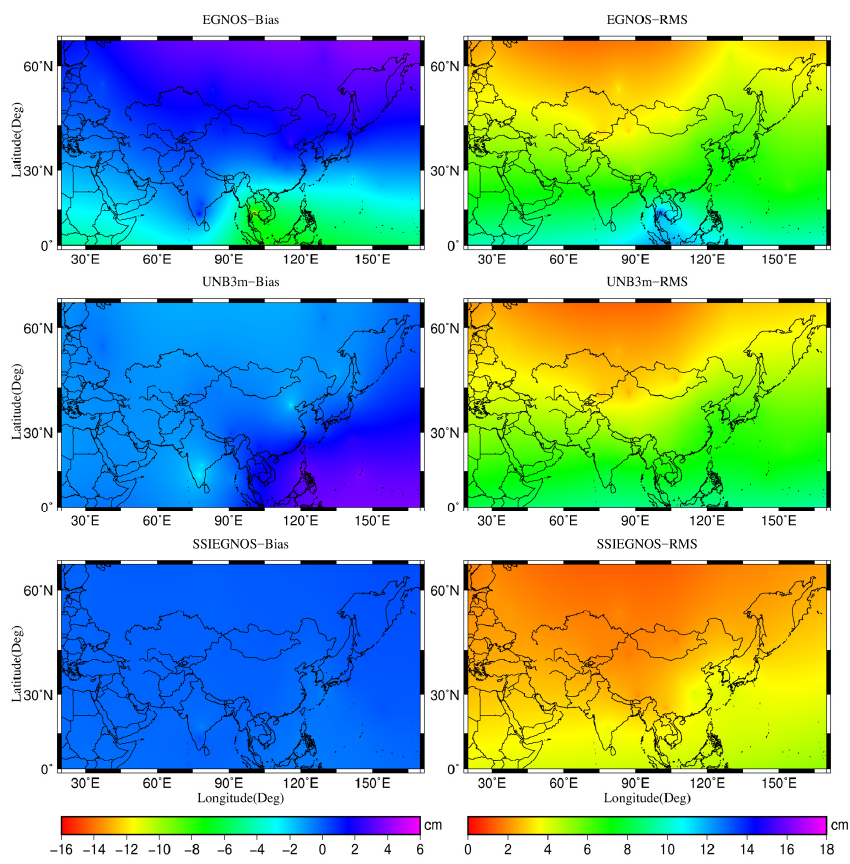
Figure 9. The distribution of the annual predicted bias and RMS error of the EGNOS, UNB3m, and SSIEGNOS models over Asia in 2011. The color denotes the magnitudes of the annual predicted bias and RMS error. Table 2. Statistics of predicted bias and RMS error of the EGNOS, UNB3m, and SSIEGNOS models over Asia.